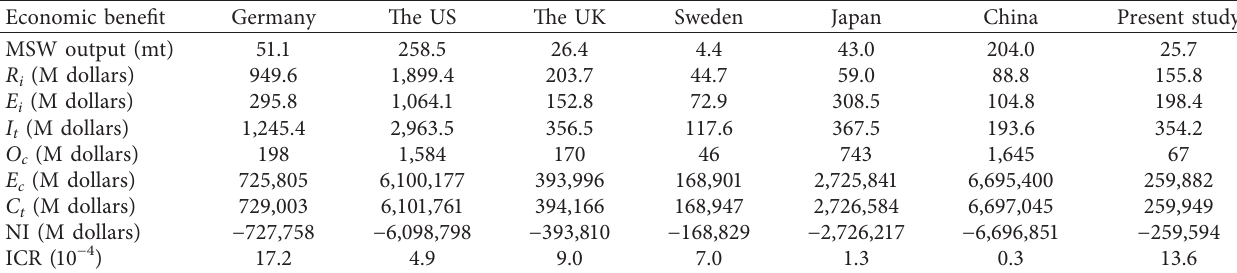
Table 4: Economic benefits of MSW classification in Germany, the US, the UK, Sweden, Japan, China, and the study. Economic